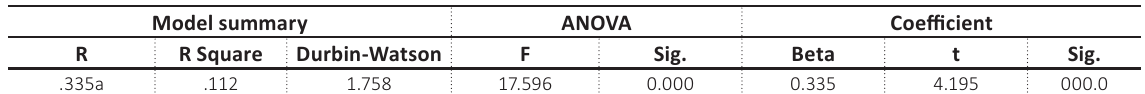
Table 5. Simple regression results